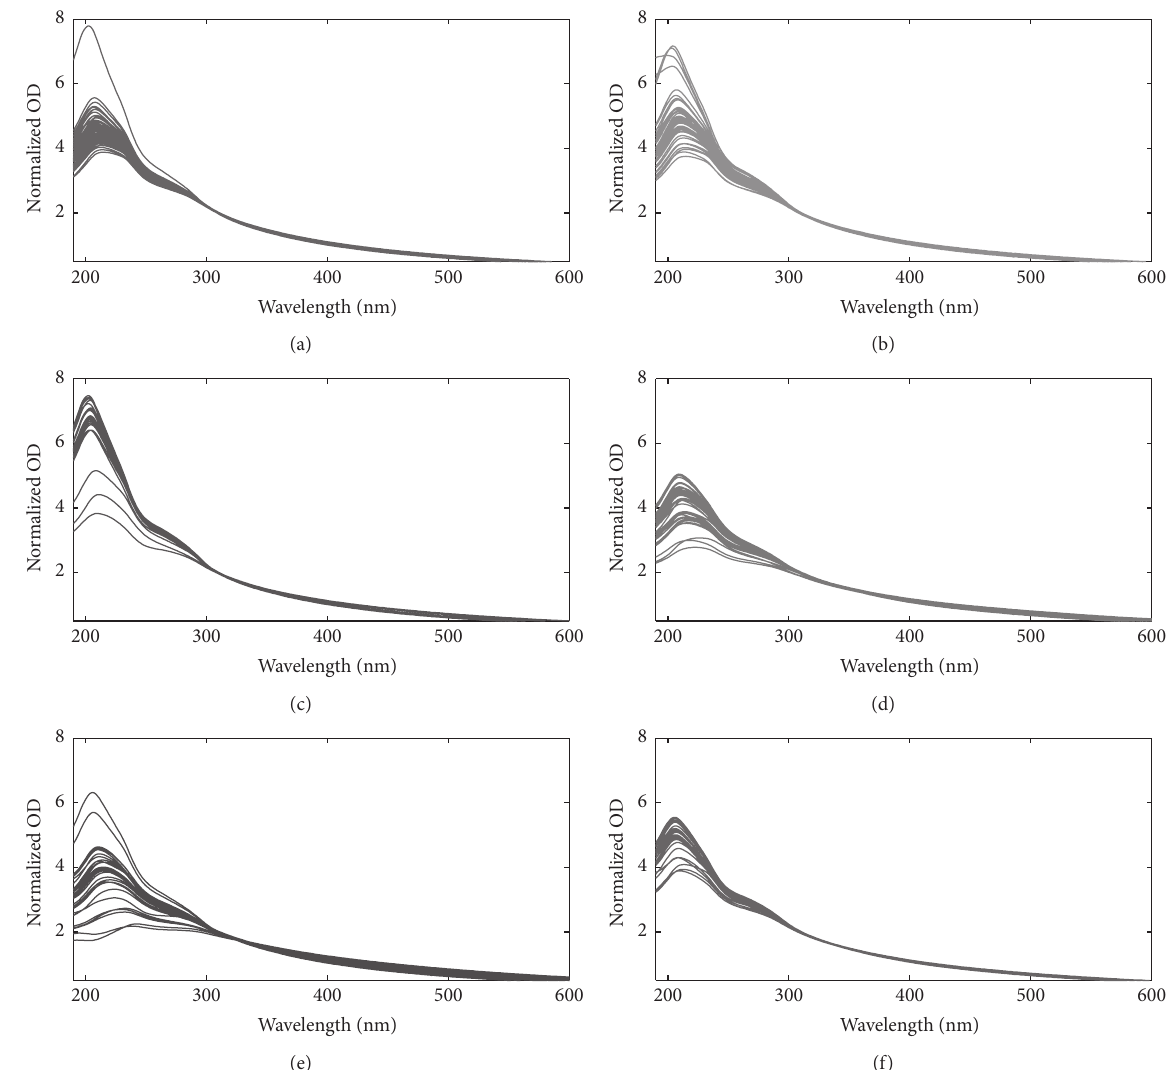
Figure 5: Comparison of the transmission spectra of clinical isolates of target organisms: E. coli (a), K. pneumoniae (b), P. aeruginosa (c), S. aureus (d), CNS (e), and E. faecalis